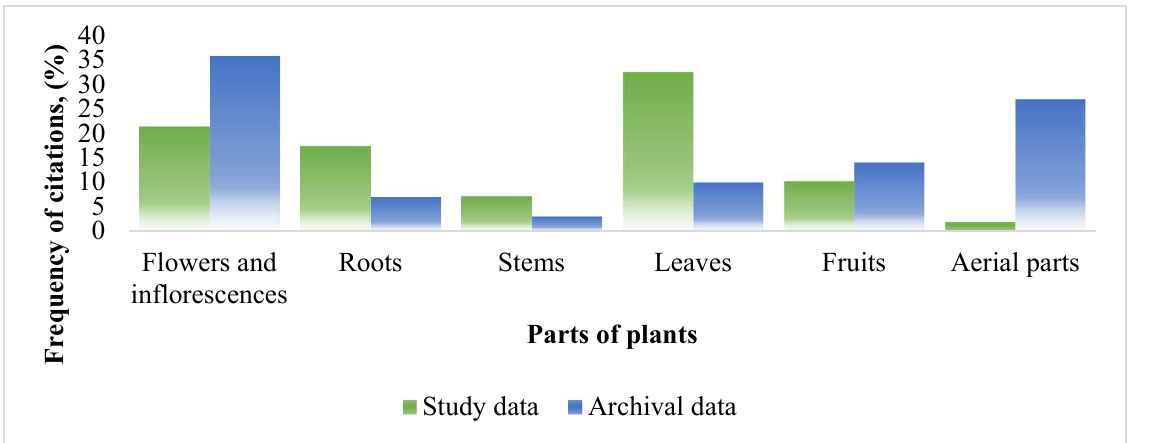
Figure 4. A comparison of the plant parts used in the ethnopharmacological study in the Pasvalys district and in the archival source .